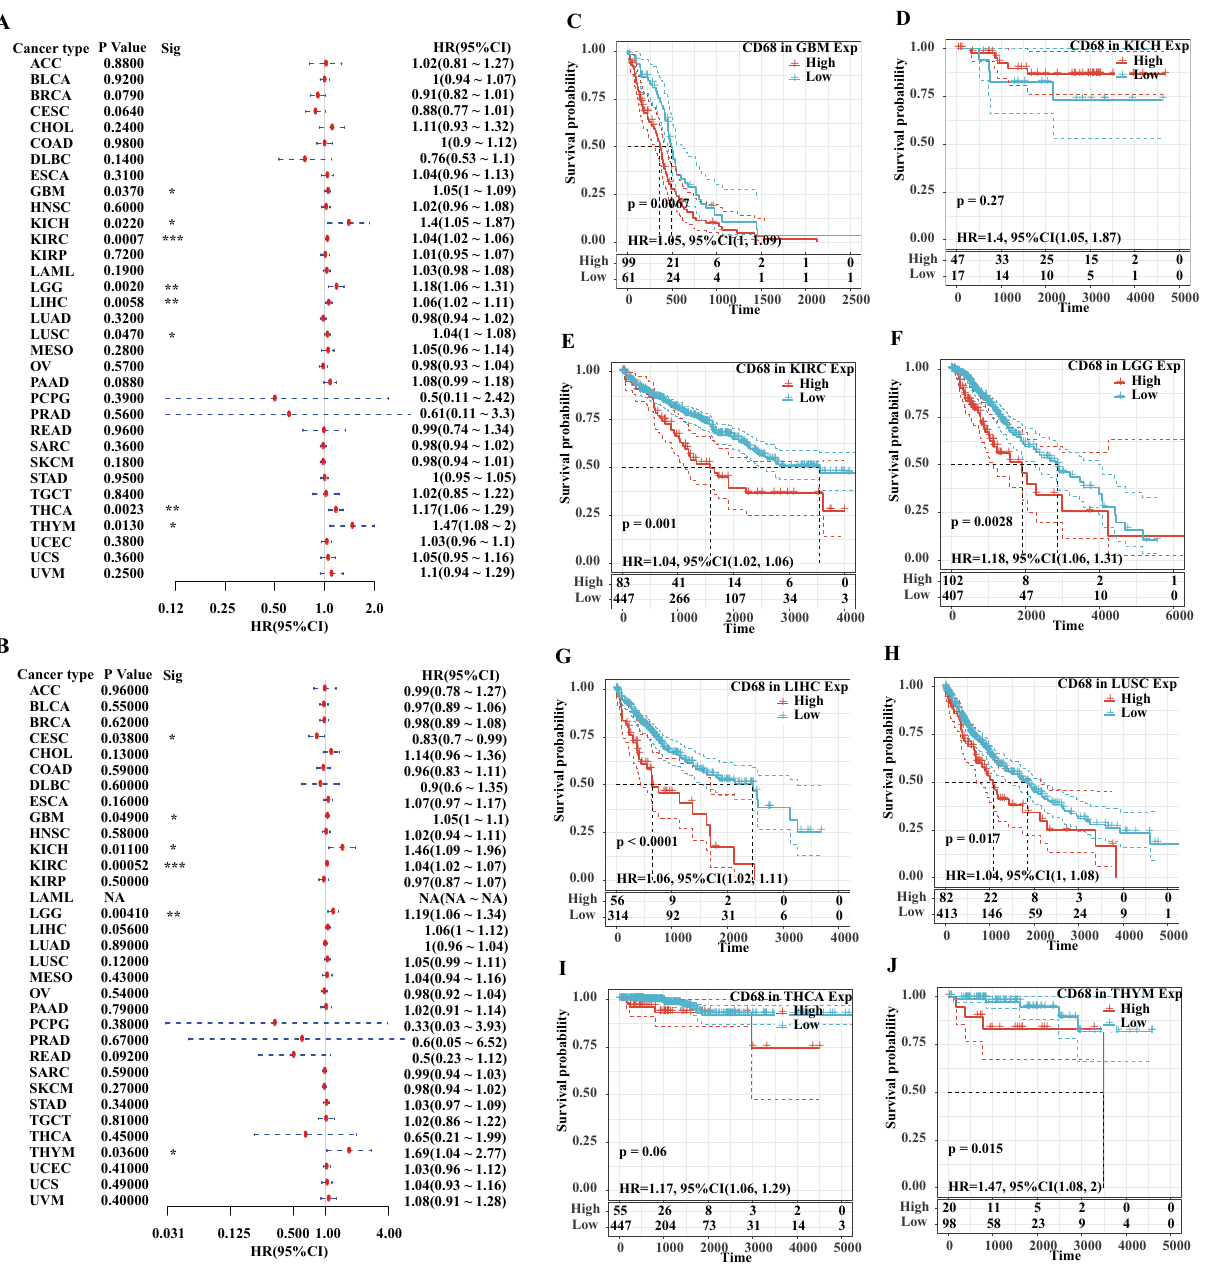
Figure 3. Survival analysis of CD68 in pan-cancer from the TCGA database. Forest plot compared the prognostic value of CD68 on OS ( A ) and DSS ( B ) across pan-cancer. Kaplan–Meier Method displayed the prognostic value of CD68 on OS in GBM ( C ), KICH ( D ), KIRC ( E ), LGG ( F ), LIHC ( G ), LUSC ( H ), THCA ( I ), THYM ( J ). The cut-off points are 61.89% (GBM), 73.44% (KICH), 15.66% (KIRC), 20.04% (LGG), 15.14% (LIHC), 16.57% (LUSC), 10.96% (THCA), 16.95% (THYM). *P < 0.05, **P < 0.01, ***P <